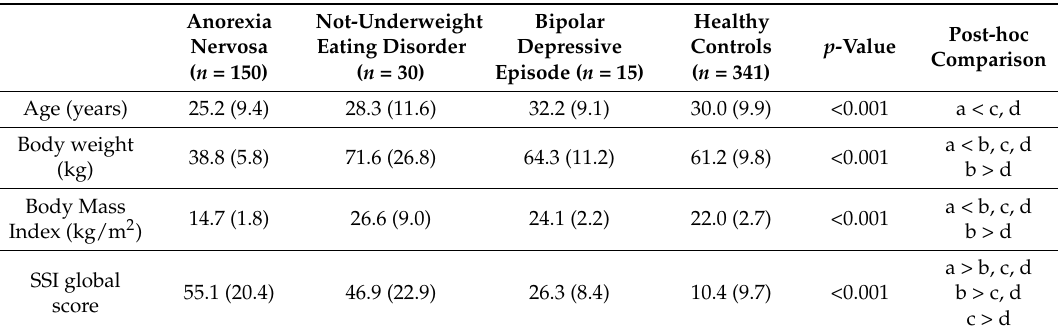
Table 2. Baseline characteristics and Starvation Symptoms Inventory (SSI) global score in patients with anorexia nervosa, not-underweight patients with an eating disorder, patients with bipolar depressive episodes and healthy